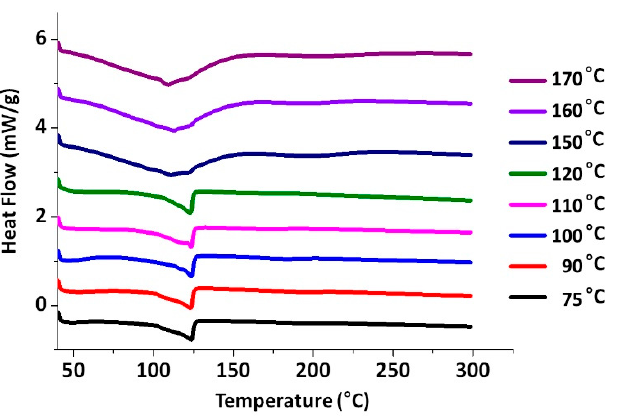
Figure 1. Dynamic scanning calorimetry (DSC) results for PE samples sulfonated at various tem- peratures.